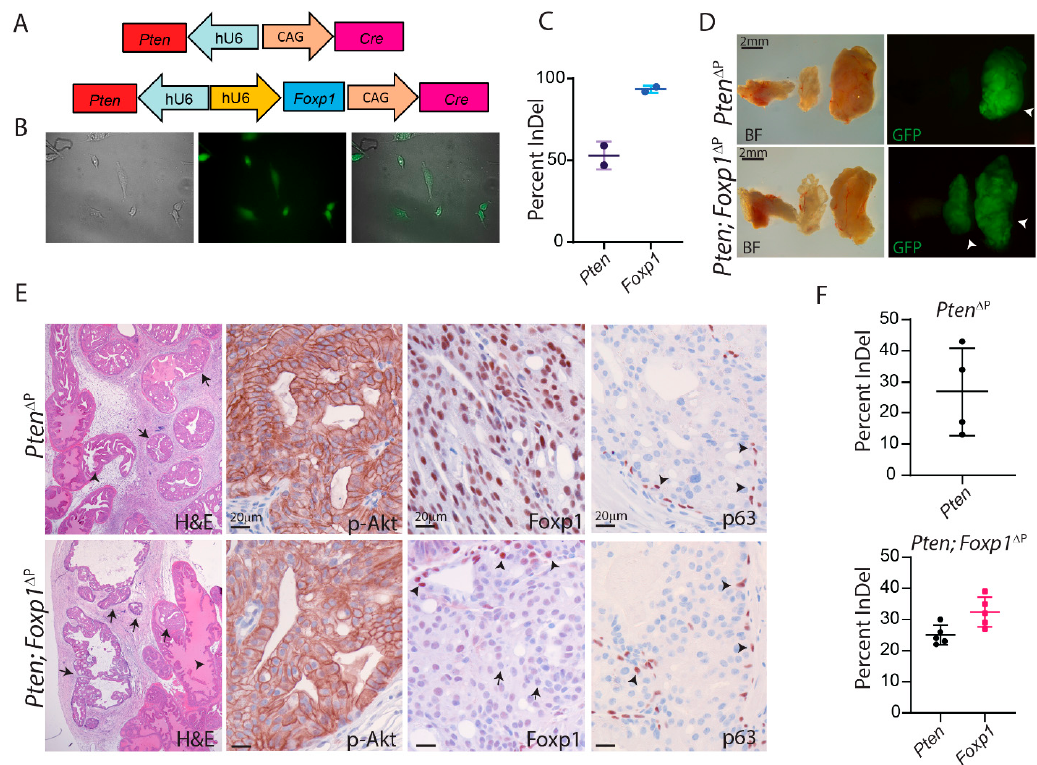
Figure 2. CRISPR generated loss of Foxp1 and Pten in the murine prostate. ( A ) AAV constructs for expression of sgRNAs to Pten or Pten and Foxp1 together with expression of Cre protein were generated. ( B ) Validation of the AAV particles were conducted in MEF isolated from Cas9-EGFP flox/flox mice. The expression of EGFP revealed viral transduction and Cre expression from the viral construct. Images were taken with 10× magnification ( C ) The efficiency of the sgRNA was determined with Sanger Sequencing and analysed with Synthego ICE software. ( D ) The AAV particles were delivered to the murine prostate with surgical injections and prostate tissues were examined 4 months post-treatment. White arrowheads mark transformed areas in the prostatic tissues (representative image, n = 5). ( E ) Paraffin sections from the prostates were stained for H & E (arrows mark PIN and arrowheads mark normal prostatic epithelial), p-Akt, Foxp1 and p63 (brown stain) to confirm PIN formation and disruption to the Pten pathway and loss of Foxp1 in the Cas9-EGFP transgene mice ( n = 5). Arrows mark cells depleted for Foxp1 and arrowheads mark cells positive for Foxp1 or p63. ( F ) Indel frequency was measured on EGFP-positive biopics from the anterior prostate lobe. Sanger Sequencing data were analysed with Synthego ICE software ( n =